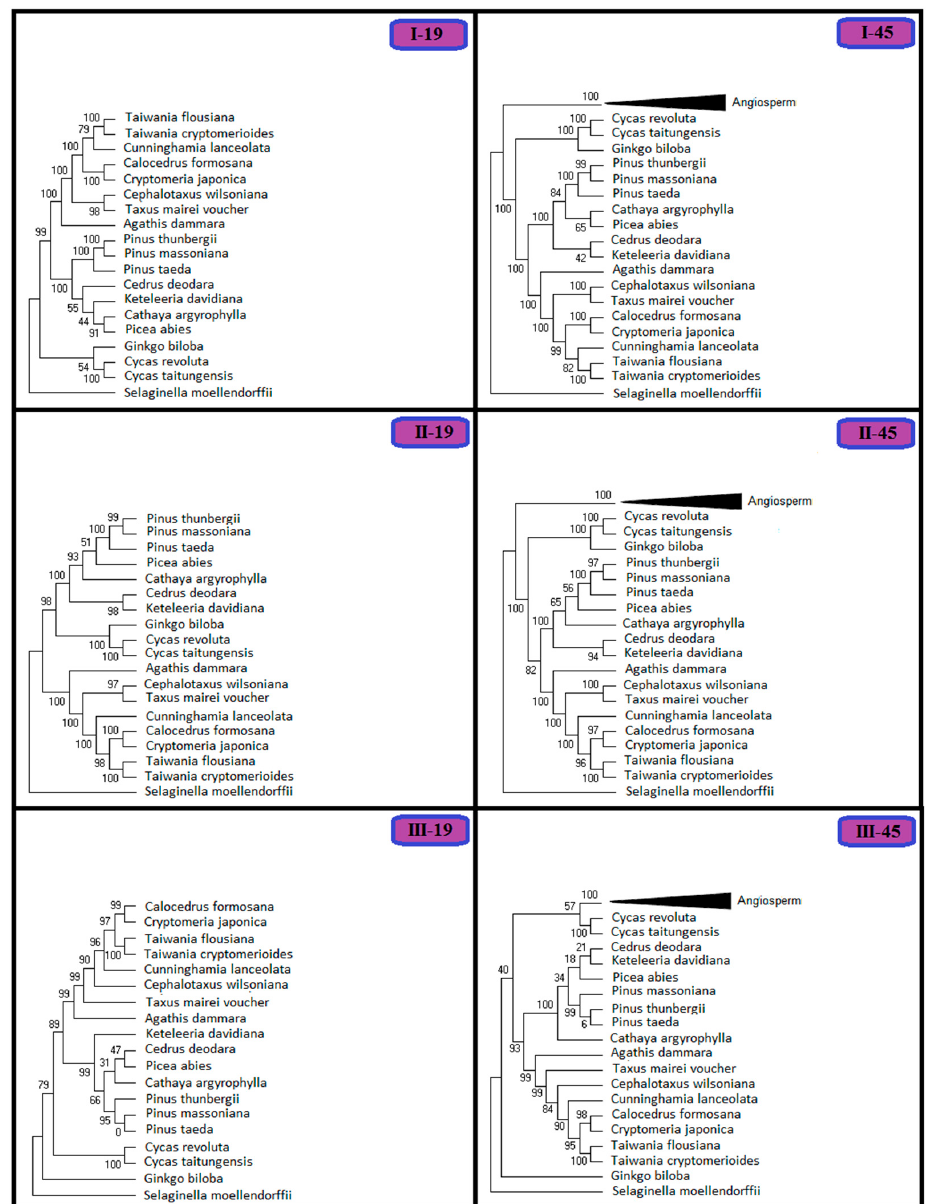
Figure 5. Phylogenetic trees based on the different gene functional groups in the 19-species matrix and the 45-species matrix, respectively. I, II and III represent three main categories of functional genes: ( I ) photosynthetic electron transport and related processes; ( II ) gene expression; and ( III ) other genes.